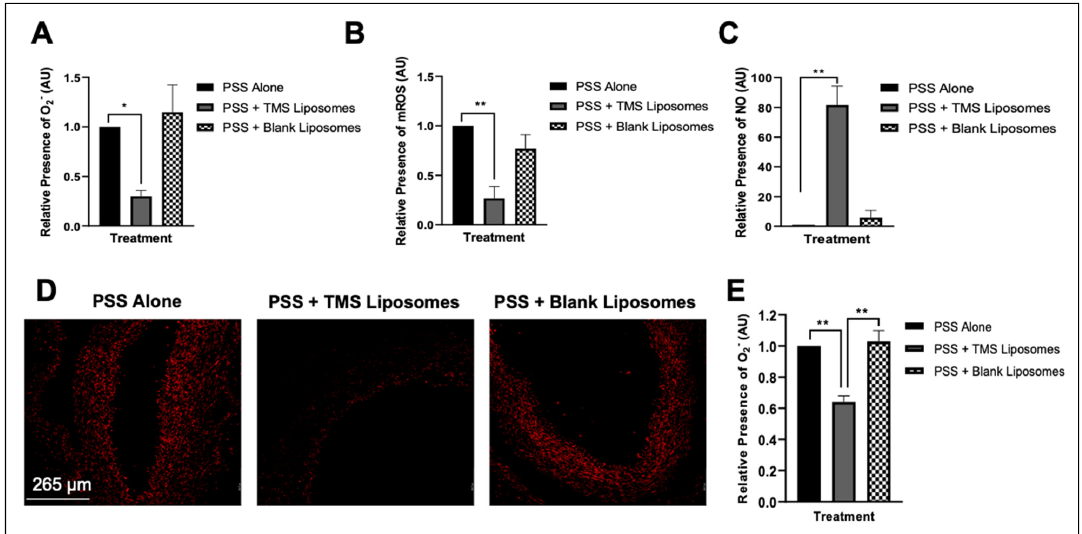
Figure 5. The corrective influence of Tetramethoxystilbene (TMS)-loaded liposomes on levels of reactive oxygen species (ROS) moieties and nitric oxide (NO) bioavailability within isolated left internal mam- mary arteries (IMAs) from coronary artery bypass graft (CABG) patients. TMSloaded liposomes reduce relative fluorescence of superoxide anion (O 2 − ) (Dihydroethidium fluorescence, DHE; ( A )) and mito- chondrial ROS (MitoSOX; ( B )) and increases intracellular NO as measured by Diamino fluorescein-FM diacetate (DAF-FM DA; ( C )) in isolated IMAs. Fluorescence data are expressed as mean fluorescence intensity (percentage of control). n = 4. Representative fluorescence micrographs ( D ) and semiquantita- tive analysis ( E ) of DHE signal intensities in IMA sections. In the absence of TMS-loaded liposomes, strong fluorescent DHE signals were observed, while vessels incubated with TMS-loaded liposomes exhibited a weak DHE signal. Images are representative for 10 sections per vessel: n = 3 vessels per group. Values for semiquantitative analysis of fluorescence signal intensities were normalized to IMA controls (physiological salt solution (PSS) alone). Magnification × 10. Scale bar = 265 µ m. Oneway ANOVA followed by a Dunnett’s multiple comparisons test. * p < 0.05, ** p <